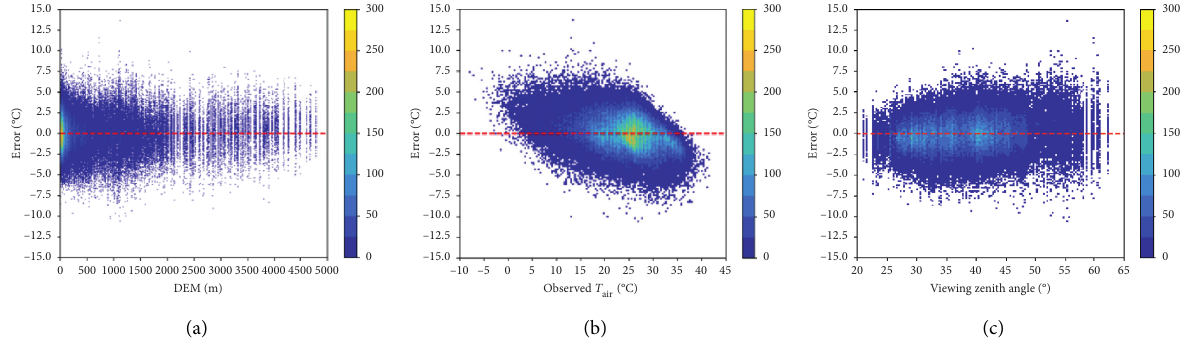
Figure 11: Scatter plot of T air error with (a) DEM, (b) observed T air , and (c) VZA for the XGB